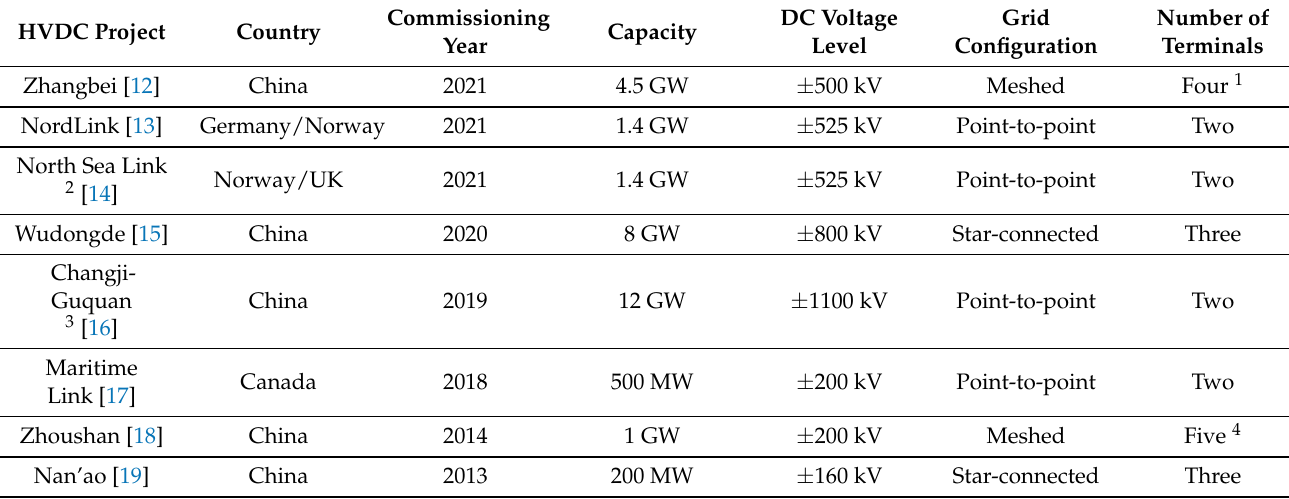
Table 2. Existing HVDC projects